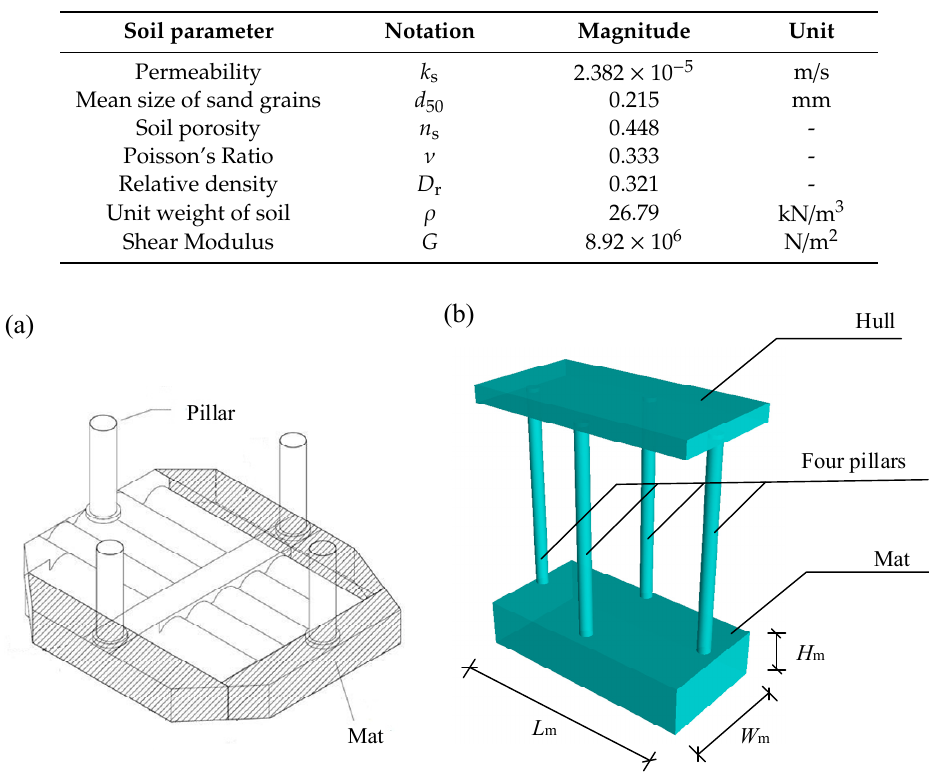
Figure 1. The configuration of the mat foundation, ( a ) real mat foundation and ( b ) model mat